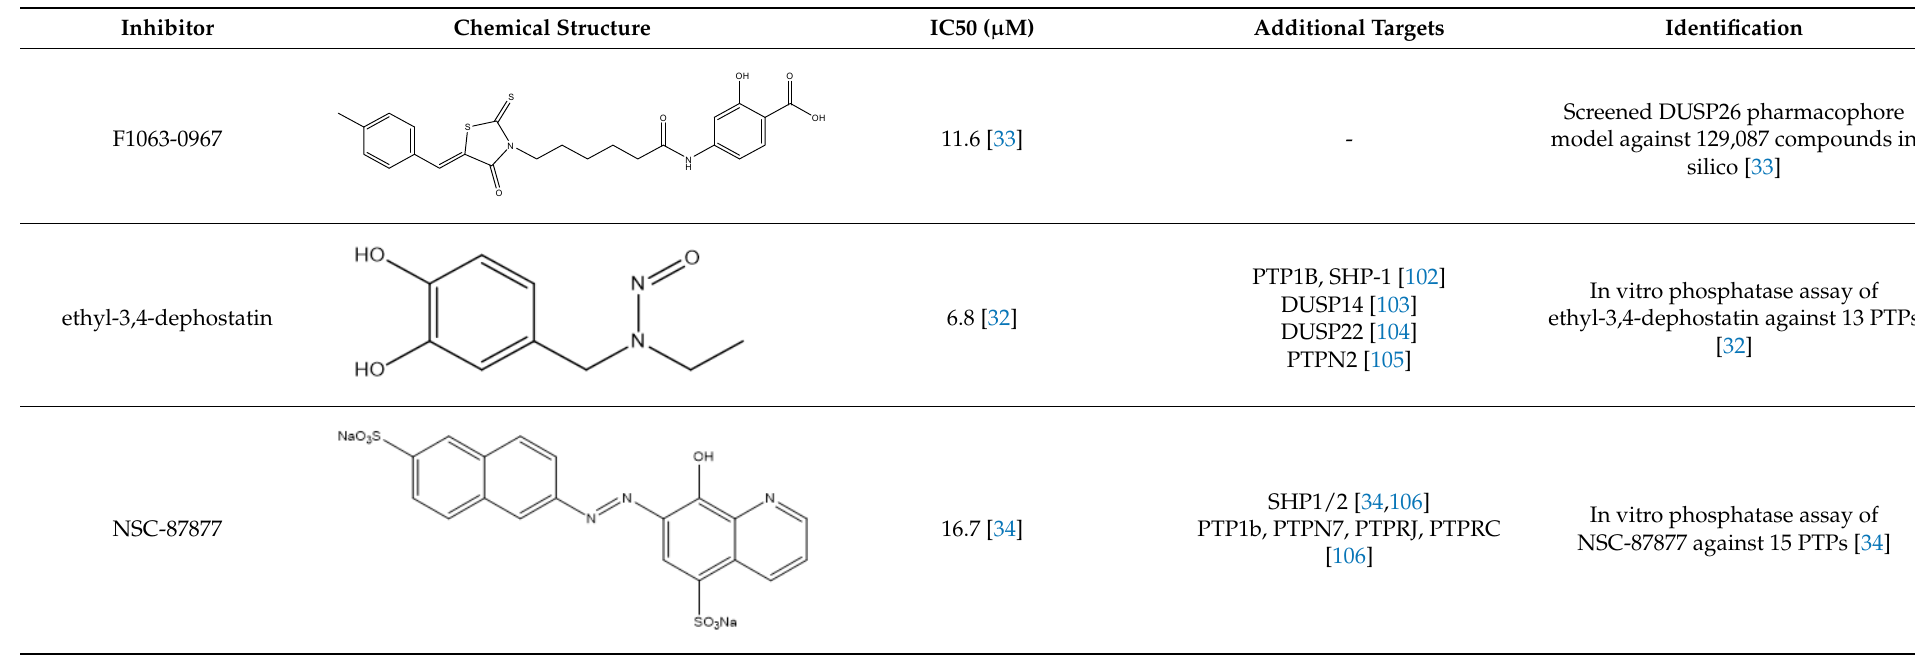
Table 3. Chemical inhibitors identified against DUSP26.